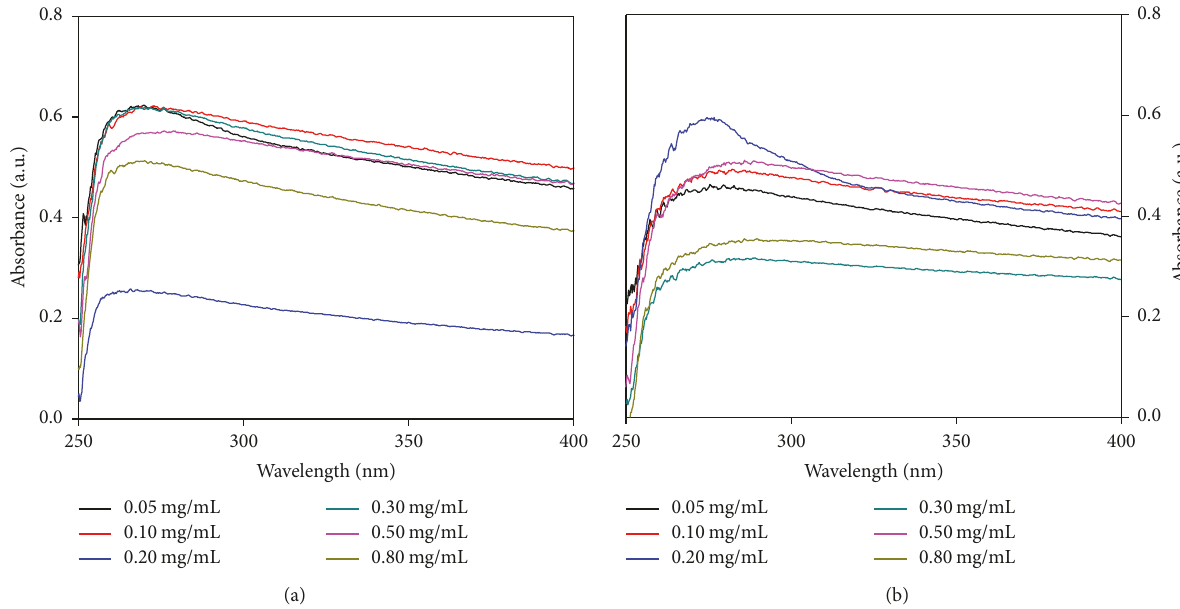
Figure 4: (a) UV-Vis spectra from the dispersion of CNTs using EDTA and (b) using SDS as surfactant agents.